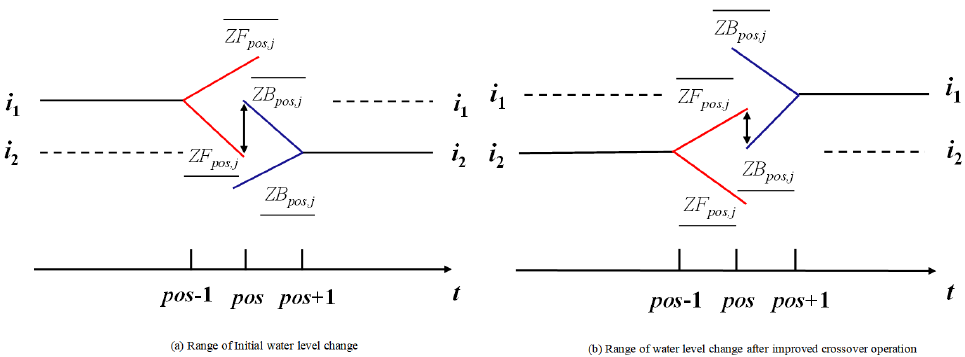
Figure 6. Schematic diagram for improved crossover